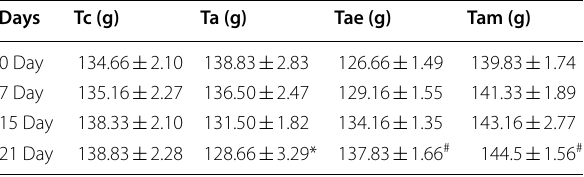
Values are mean SEM ( n 6); *Significant at 5% level, **Significant at 1% level ± = and # Not significant The fluctuations in body weight in different groups are stated in Table 1. There was a significant ( p < 0.05) decline in body weight in all alloxan-induced type I diabetic rats compared to the control group within 21 days